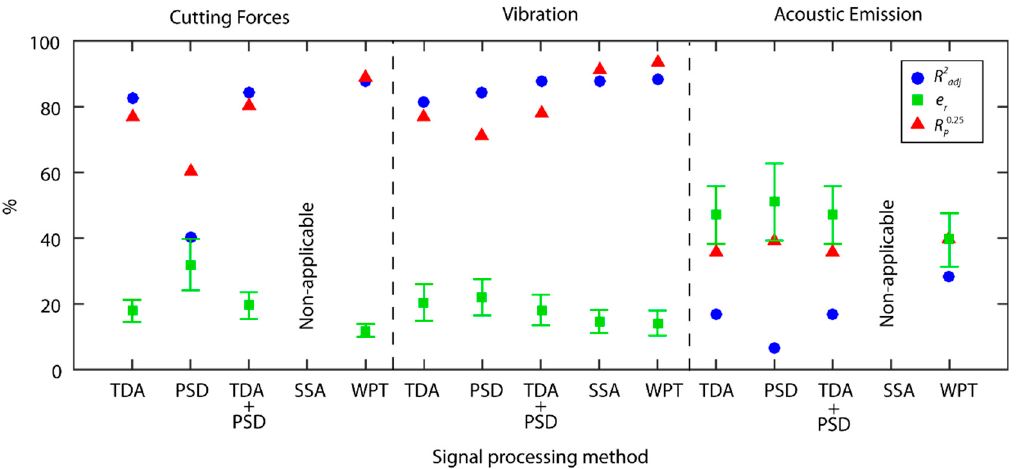
Figure 16. Comparison of the predictive results according to processing method and signal type.